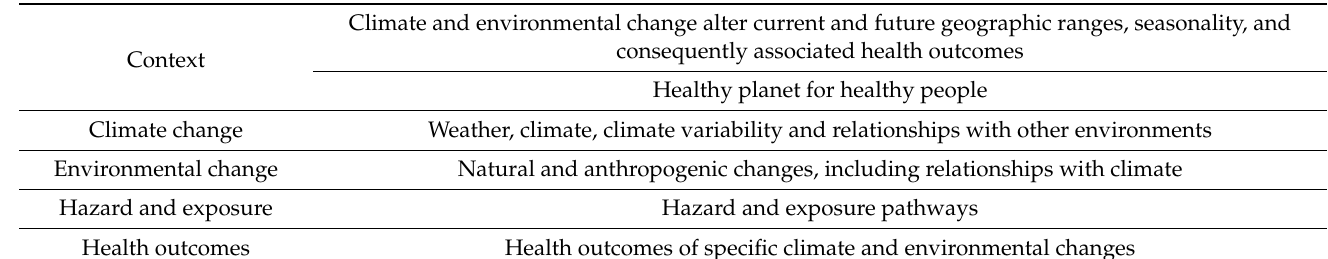
Table 2. Competencies for Domain 1: Climate, Environmental Change and associated Health Sciences.